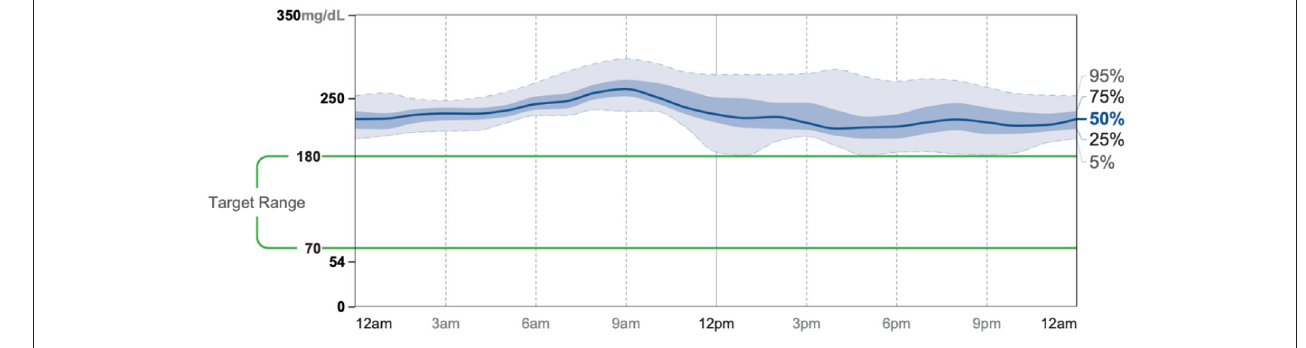
FIGURE 7 | AGP 7/19-8/1.